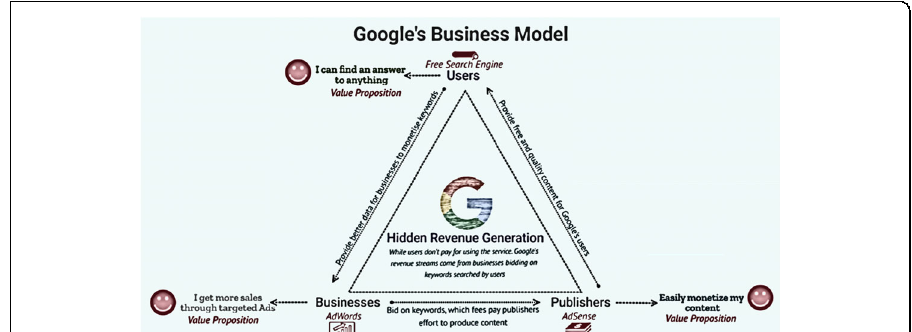
Fig. 6 Google business model (Google Business, 2020)